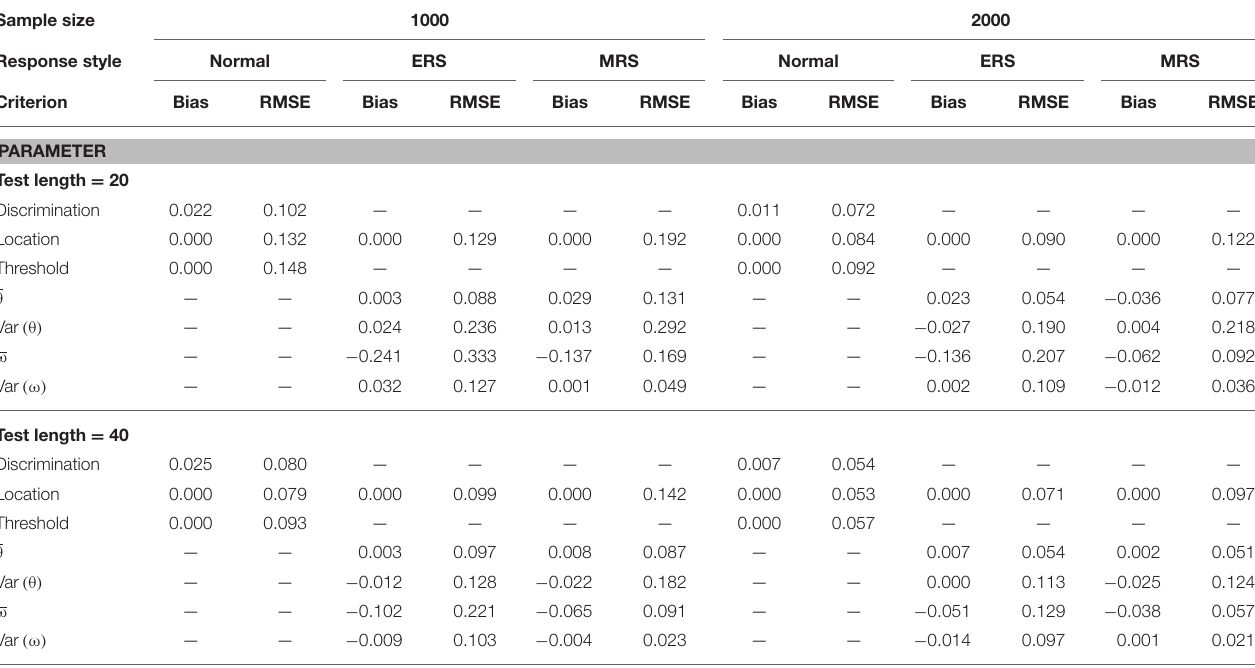
TABLE 1 | Mean bias and RMSE of the model parameter estimates for the mixture ERS-GPCM on 4-point items. Sample size